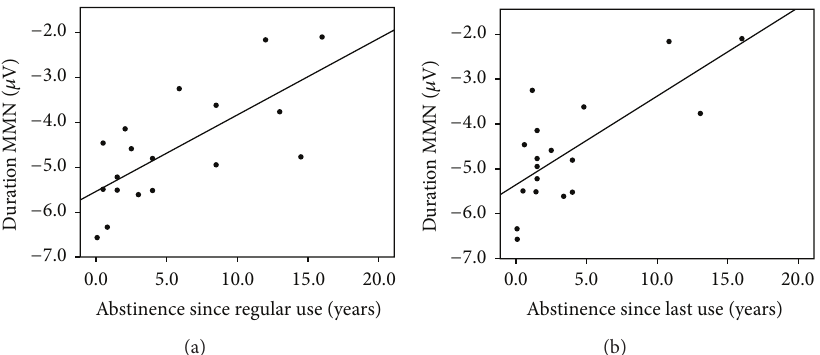
Figure 2: Scatter plots showing association between duration MMN amplitude ( 𝜇 V) and duration of abstinence since last regular cannabis use (a) and abstinence since the last occasion of use (b).